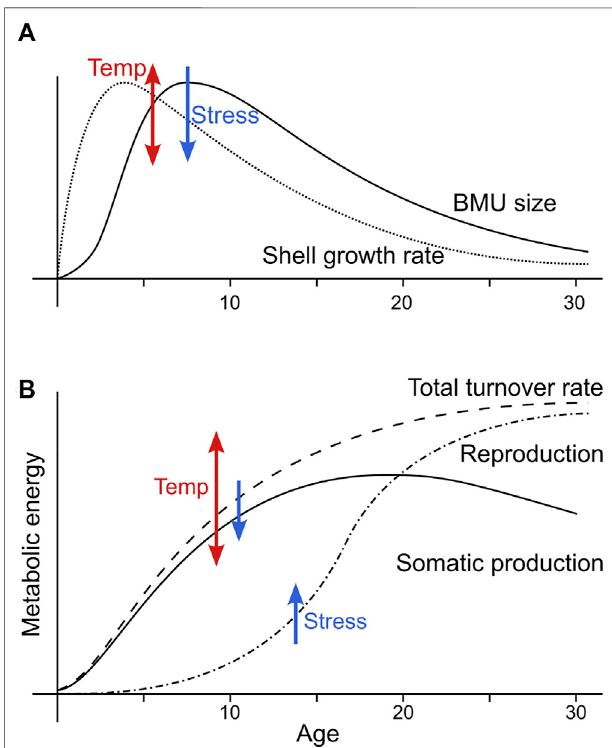
FIGURE 9 | Interpretation of the coupling between the BMU size of A. islandica shellsandearlyshiftsintheirmetabolism. (A) SketchofBMUsizeand shell growth rate patterns over lifetime observed in this study. Both parameters fi rst increased then decreased over lifetime, with their maxima offset by two to 4 years. The levels of BMU size and shell growth rate as well as the amplitude of their changes over lifetime were increased by warmer temperature, whereas stressful environmental conditions led to a decrease. (B) Sketch of energetic developments during the early life stage of A. islandica , after Abele et al. (2008) and Begum et al. (2010). Somatic production (i.e., growth of shell and soft tissue) are prioritized at young age, causing the patterns seen in A. After reaching a suf fi cient size to escape predation, shell growth slows down because the metabolism prioritizes maturation and reproduction. For further explanations see